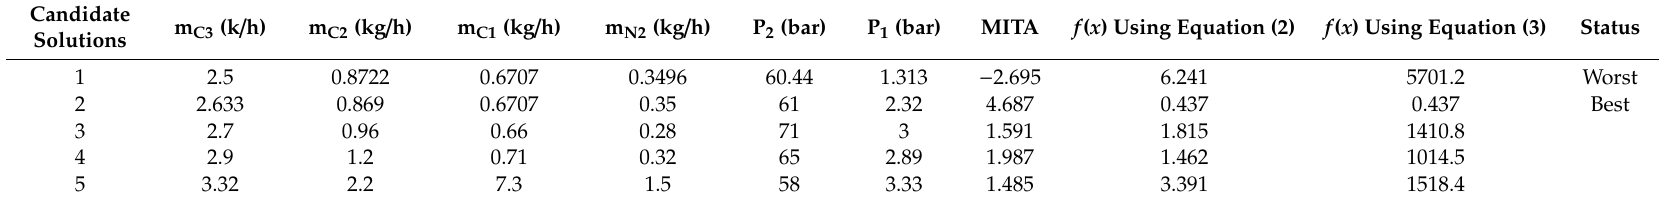
Table 6. Initial population generated over decision variables of the SMR